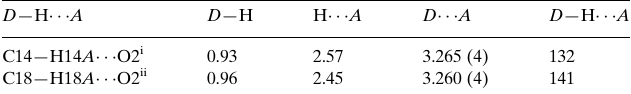
Hydrogen-bond geometry (A˚ , (cid:2)